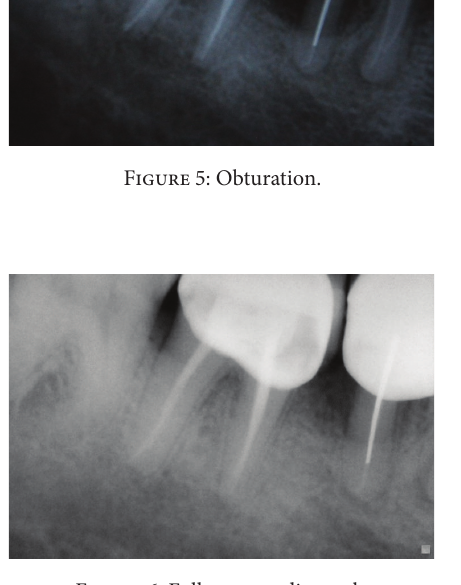
Figure 6: Follow-up